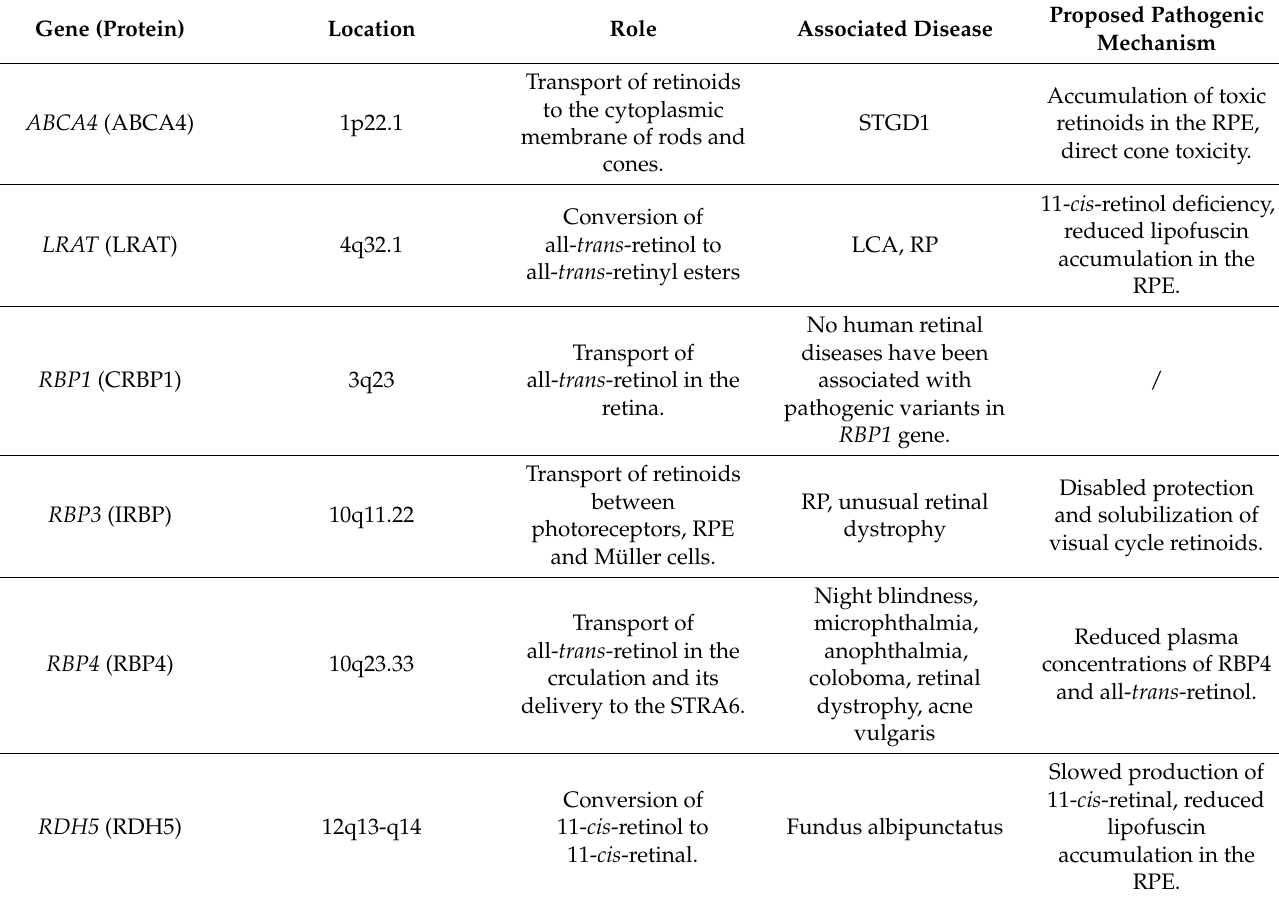
Table 1. Summary of roles and pathogenetic mechanisms in diseases associated with vitamin A